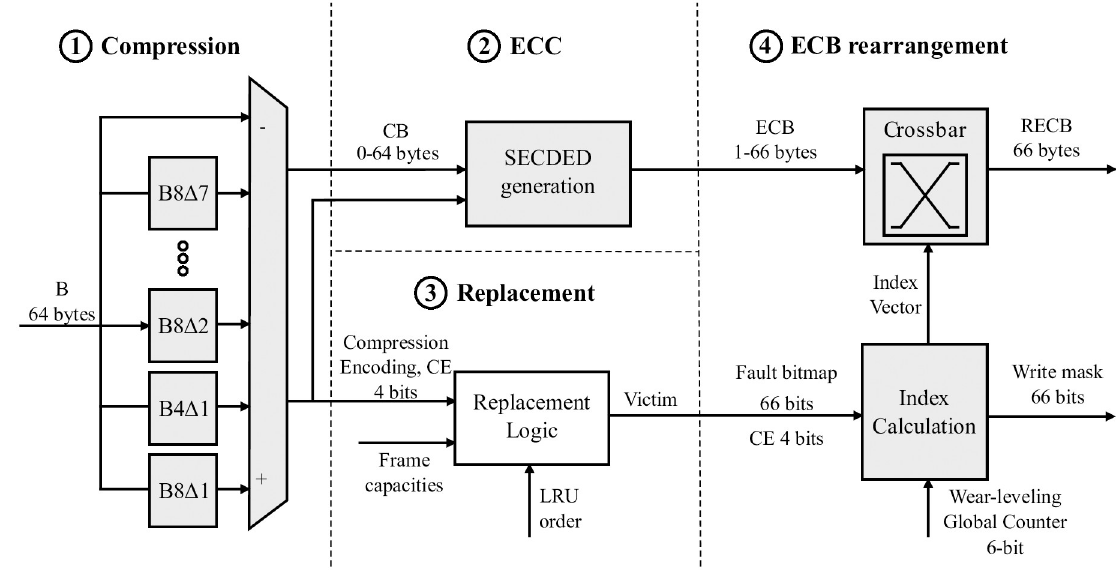
Fig 5. Flow of writing a block in L2C2 and components